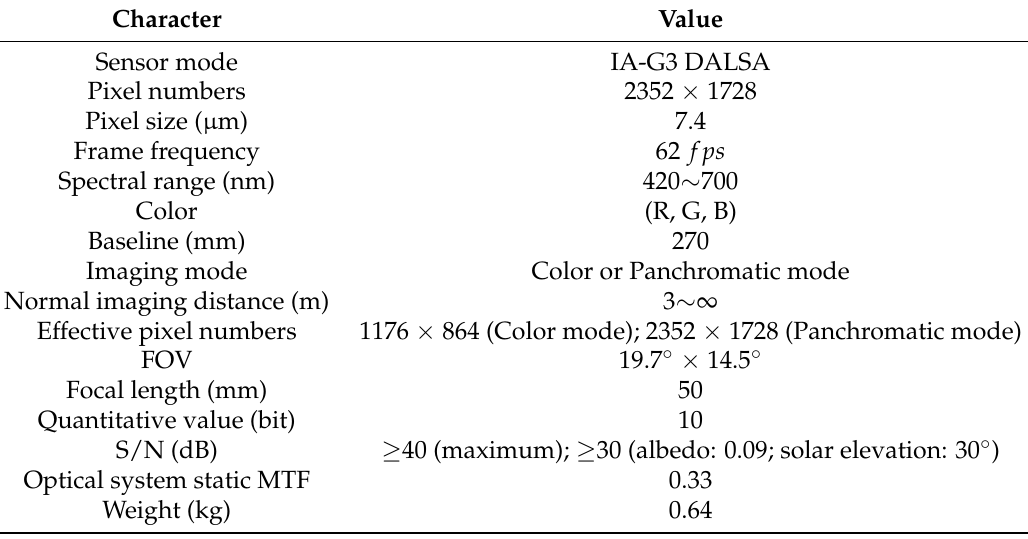
Table 1. Technical Indices of CE-3 PCAM (Panoramic Camera).